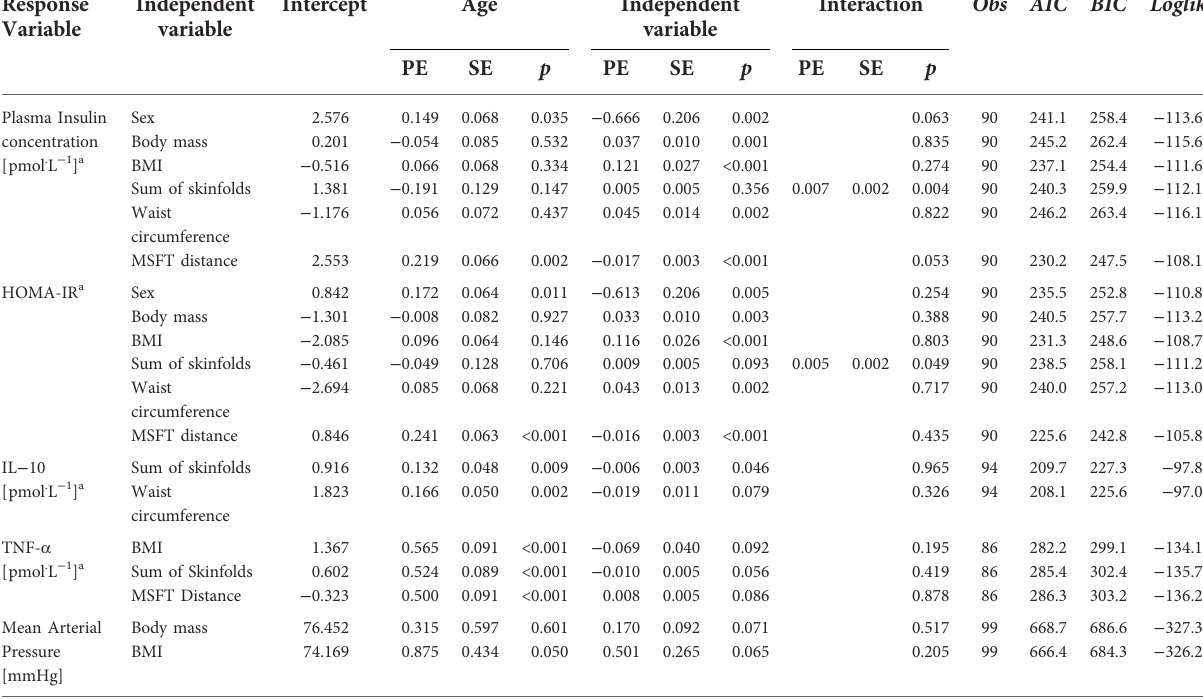
TABLE 3 Results of the multilevel models considering the individual effects of each independent variable on each response variable. Response